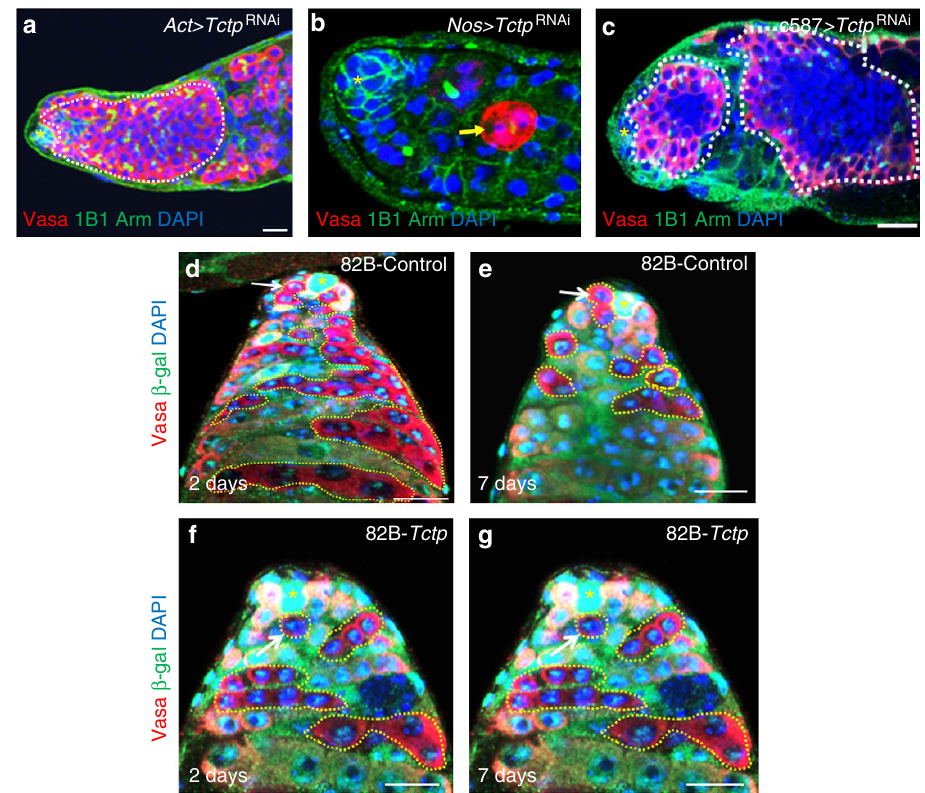
Figure 4 | TCTP differentially regulate GSCs from different cells. ( a ) Knockdown of Tctp using Act-Gal4 resulted in GSC differentiation defects. ( b ) Knockdown of Tctp using Nos-Gal4 resulted in GSC loss. ( c ) Knockdown of Tctp using c587-Gal4 resulted in GSC differentiation defects. FRT 82B -piM mosaic clones of GSCs 2 days ( d ) and 7 days ( e ) ACI. FRT 82B -Tctp h5p mosaic clones of GSCs 2 days ( f ) and 7 days ( g ) ACI. In control flies, Arm-lacZ- negative GSC clones were detected in 33 out of 37 testes 2 days ACI and in 51 out of 64 testes 7 days ACI; in Tctp h5p flies, Arm-lacZ-negative GSC clones were detected in 37 out of 53 testes 2 days ACI and in 8 out of 63 testes 7 days ACI. Thus, Tctp is intrinsically required for GSC maintenance. Testes of the indicated flies were dissected, stained with antibodies to Vasa (red, germ cells including GSCS), b -galactosidase (green) and DAPI (blue, marks the nuclei) in d – g , and Vasa (red), Arm (green, hub cells at the apex), 1B1 (green, marks round spectrosomes and branched fusomes) and DAPI (blue, marks the nuclei) in a – c , and analysed by confocal microscopy. The flies were cultured at 29 (cid:2) C for 7 days in a – c . White arrows near hub cells indicate a GSC clone ( d – f ) and yellow dotted lines in d – g indicate GSC clones. White dotted lines in a , c indicate GSC-like cells. A yellow arrow in b indicates a remaining germ cell. Asterisks indicate hub cells. Scale bars, 10 m